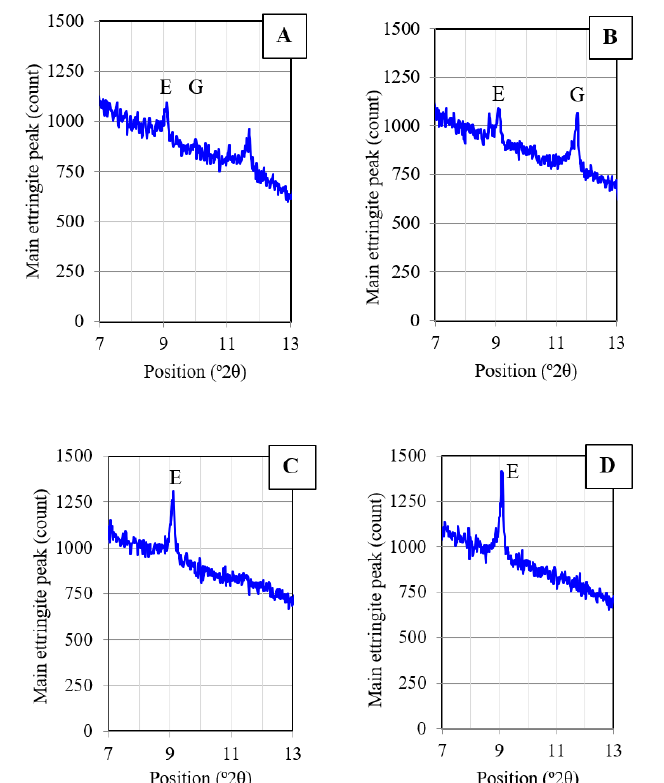
Figure 8. Comparative analysis of the main ettringite (E) peak in the diffractograms. A – Ref. (0.0% SO 3 ) at 28 days; B - Ref. (0.0% SO 3 ) at 720 days; C - (5.0% SO 3 ) at 28 days; D - (5.0% SO 3 ) at 720 days. (E – ettringite; G –